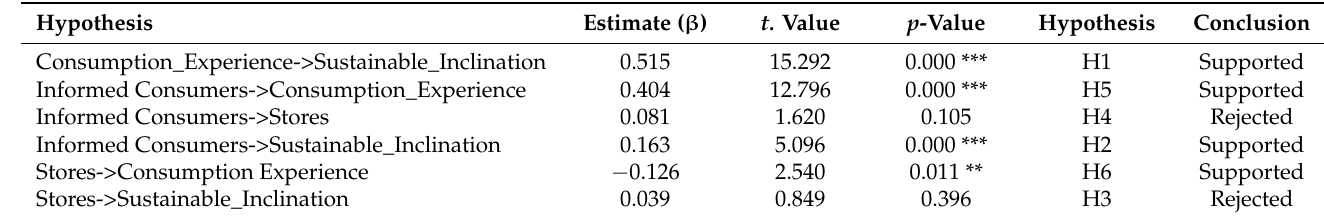
Table 7. Summary convergent validity and internal consistency of constructs.